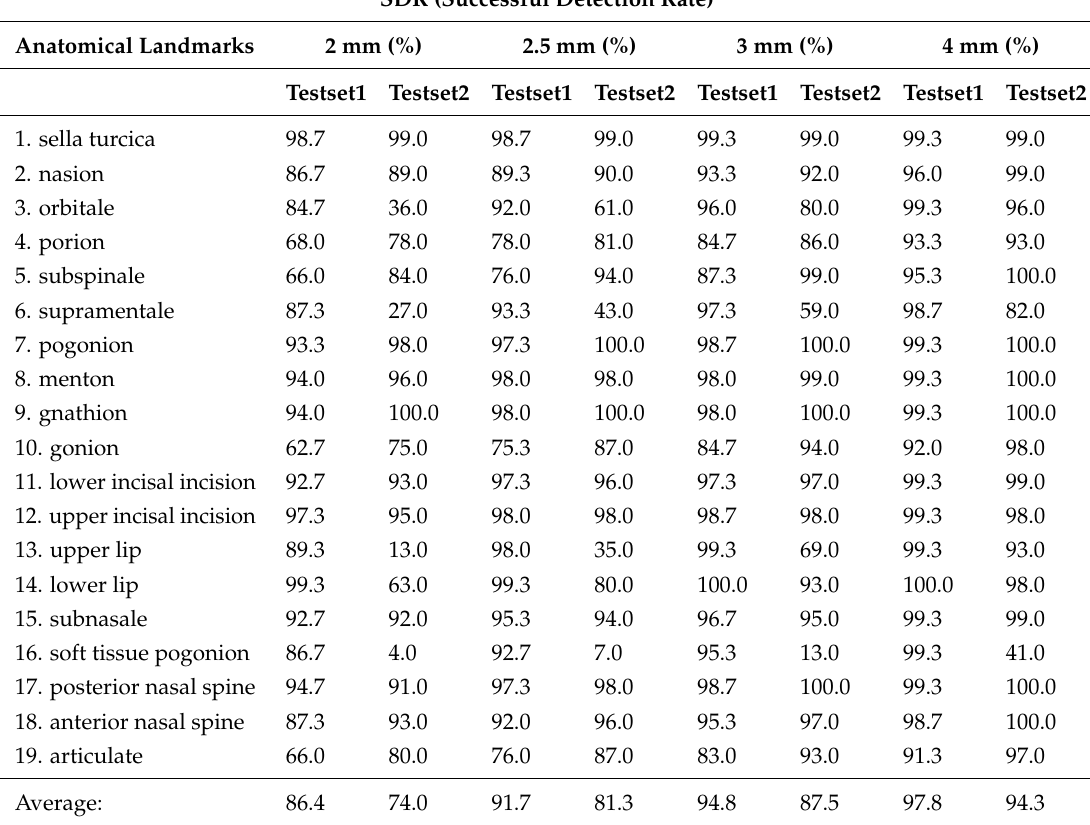
Table 1. Successful Detection Rate (SDR) Results on Testset1 and Testset2 of range 2 mm, 2.5 mm, 3 mm, 4